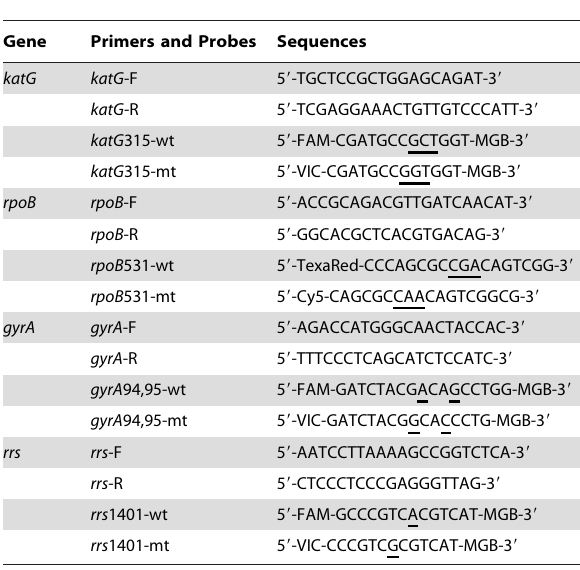
Table 1. Primer and probe sequences.